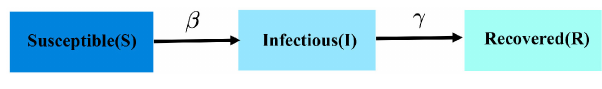
FIGURE 2 | The framework of SIR